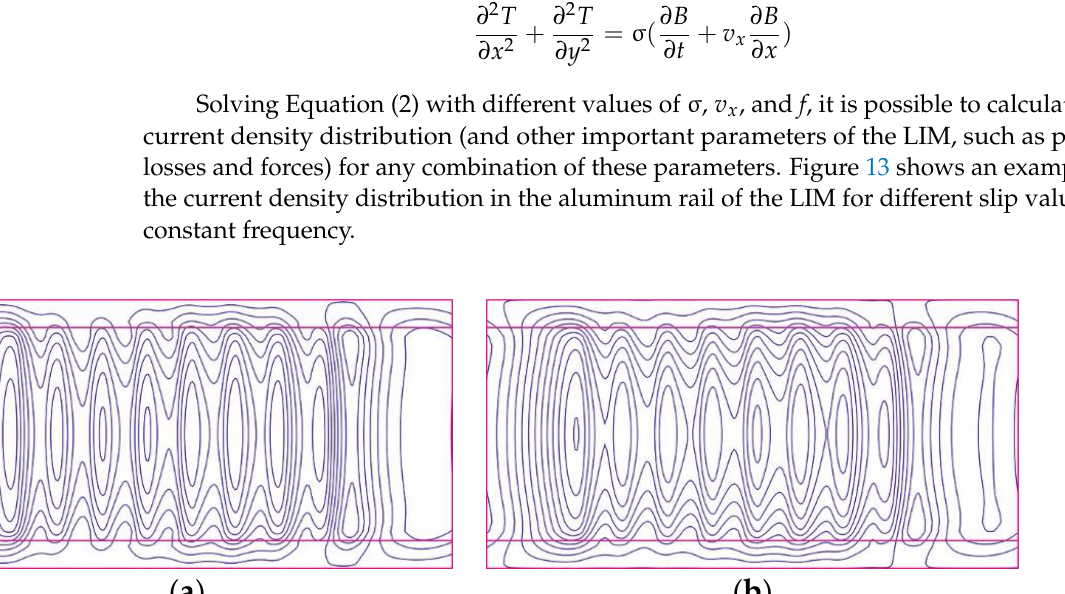
Figure 13. Current density distribution in the rail of the LIM with constant frequency and different slip values [29]. The electric vector potential method can also be applied for the calculation of eddy cur- rent distribution in the copper sheet of the rotor due to skewed armature slots (Figure 14a) and for the analysis of influence of the rotor slits on the eddy current distribu- tion in the rotor of rotating induction machines (Figure 14b).